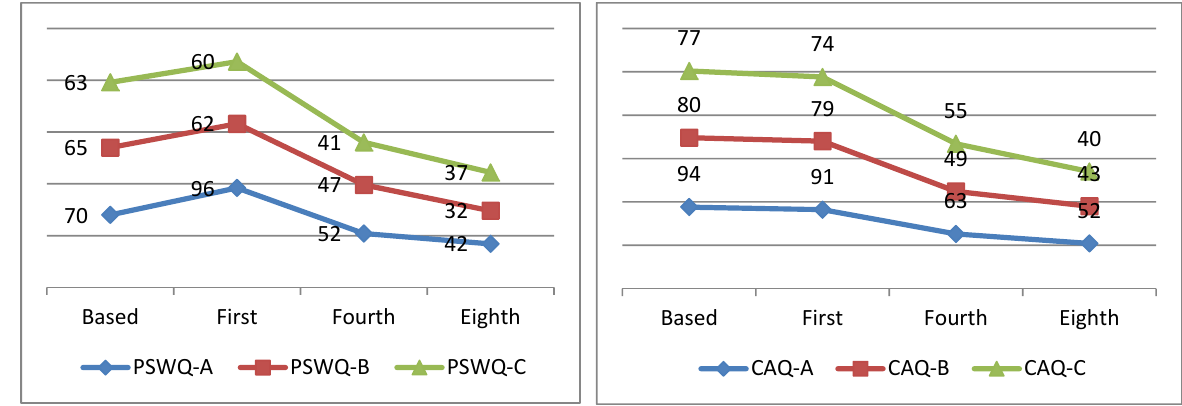
Fig. 1. The results of PSWQ and CAQ tests